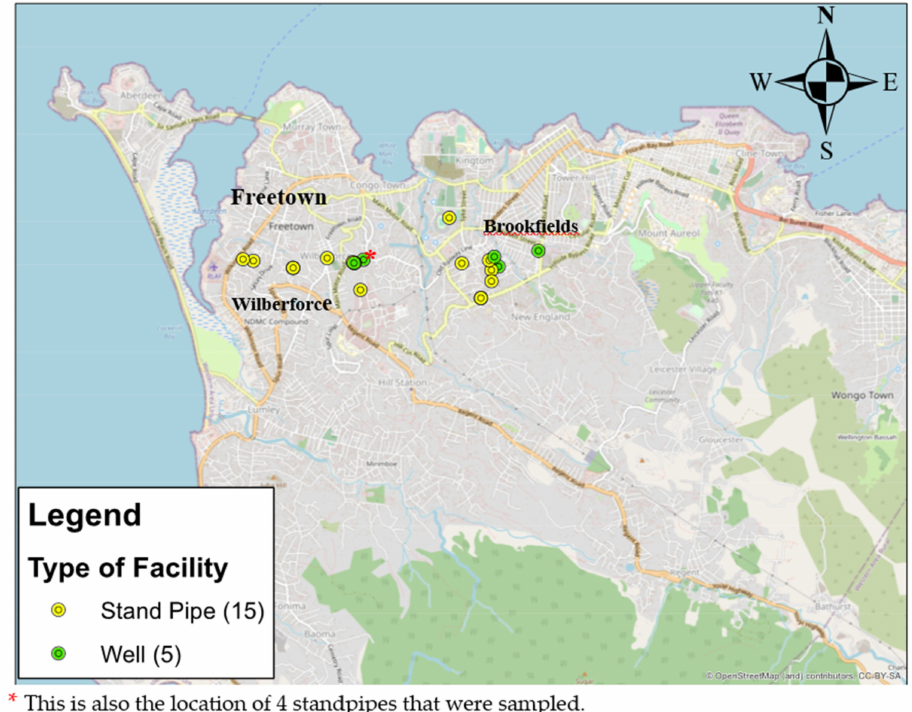
Figure 2. Map of Freetown indicating the sampling sites of the wells and standpipes in Western Area, Sierra